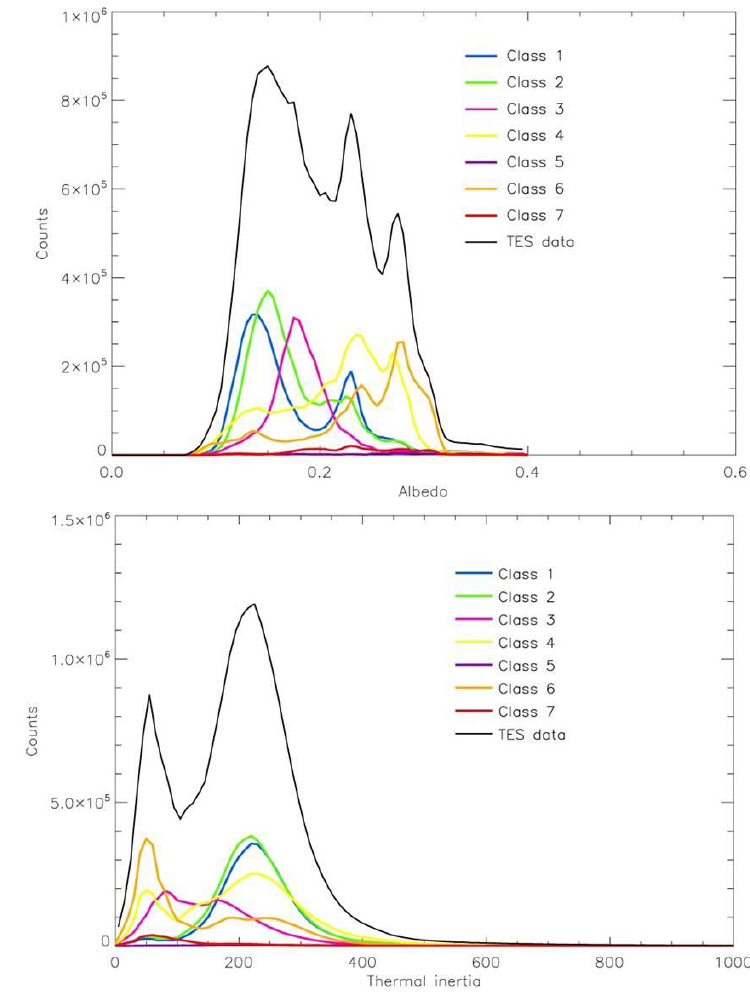
Figure 7. Histograms of classes produced by the ISODATA algorithm, compared to TES albedo ( top ) and thermal inertia ( bottom ). Binsize is 0.005 (albedo) and 10 (thermal inertia). Colours match all figures on seven classes, including the most similar classes produced by the EM of a GMM classification. The model is able to fit all peaks in thermal inertia and albedo, however two classes are bimodal in both parameters. Separate histograms for the Maximum Likelihood output are not shown as they are very